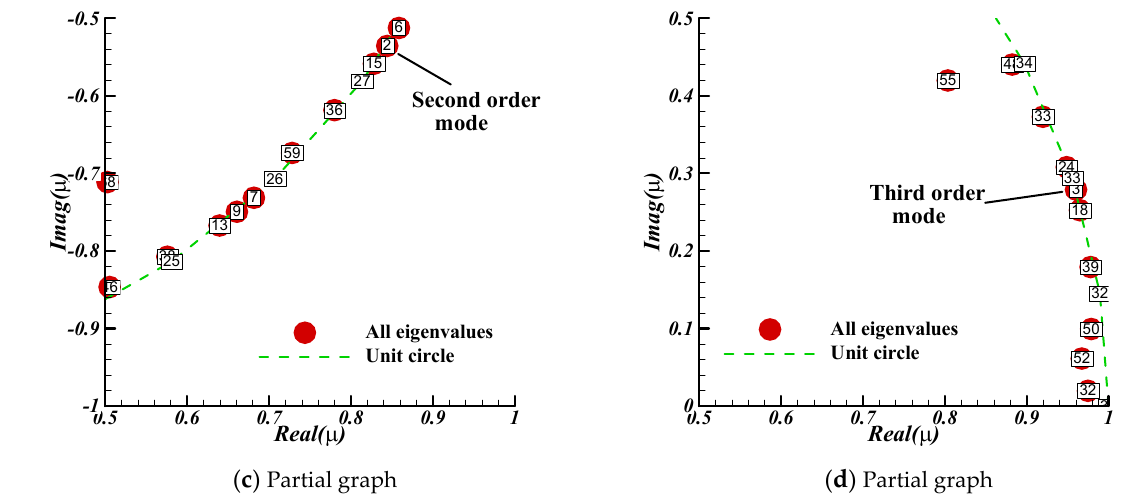
Figure 18. The DMD amplitude versus the reduced frequency.